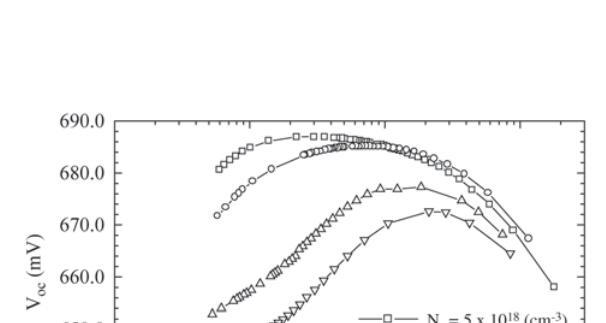
as function of emitter sheet oc , considering p-type emit- s